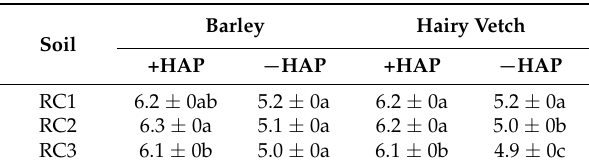
Figure 1. Water-extractable lead in rhizosphere soil (RC1–RC3) with and without hydroxyapatite (+HAP and − HAP, respectively) for ( a ) barley and ( b ) hairy vetch. Vertical bars indicate the standard error (S.E.) ( n = 3). Different letters indicate significant differences at p < 0.05 based on Tukey’s HSD test. Table 3. Effect of material on soil pH in rhizosphere ( n = 3).